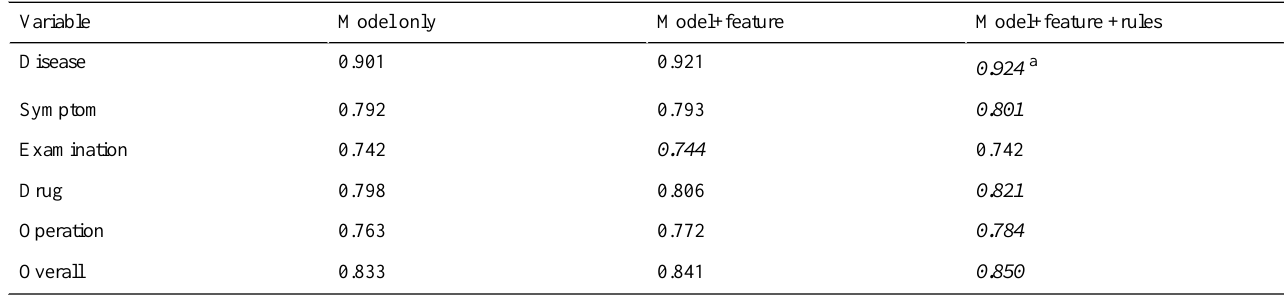
Table 7. Performance of the named entity recognition models based on the entity level F1 value.